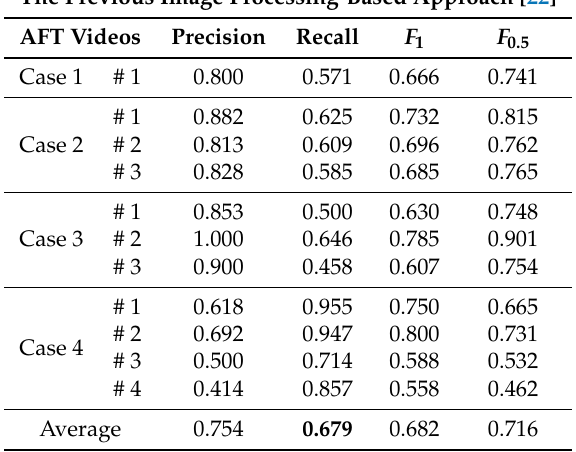
Table 4. The quantitative results for the AFT videos in terms of the precision, recall, and F-measures.